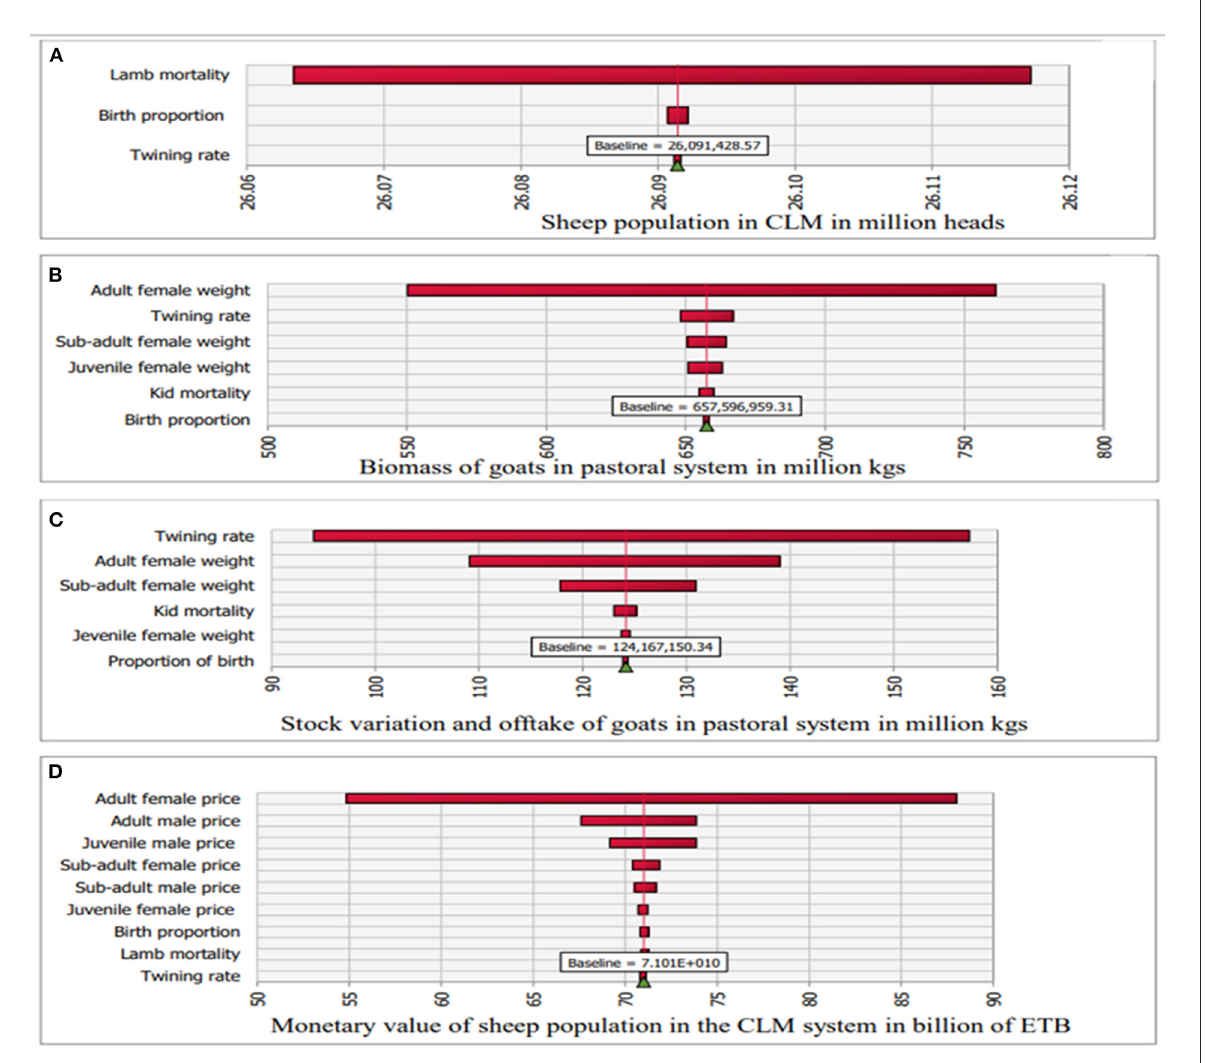
FIGURE4 Tornado plots showing sensitivity of model outputs to stochastic inputs: (A) Sheep population in CLM in million heads, (B) Biomass of goats in pastoral system in million kgs, (C) Stock variation and net offtake of goats in pastoral system in million kgs, and (D) Total monetary value of sheep population in CLM system in billions of